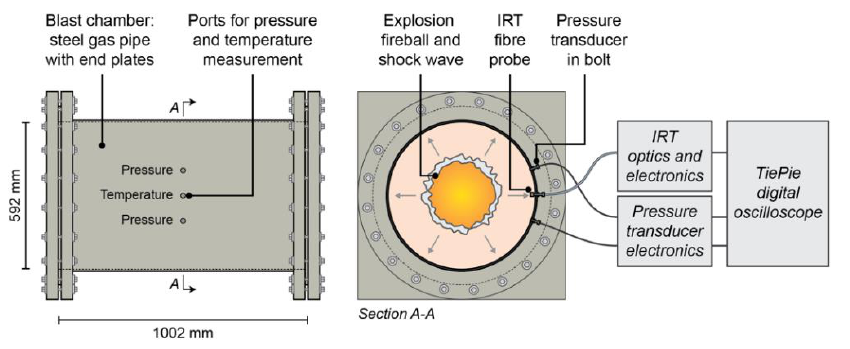
Figure 3. Test setup for blast measurement, incorporating IRT and pressure gauges instrumentation.